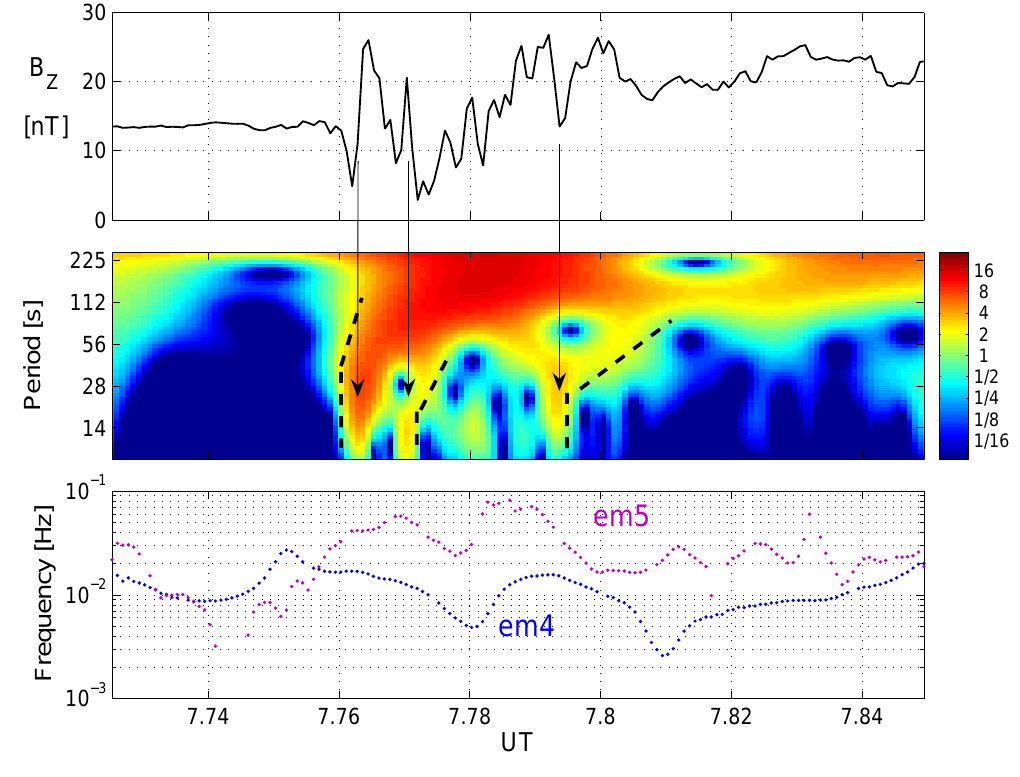
Fig. 4. Top: magnetic field time series; Middle: Wavelet time-period-energy representation; Bottom: Hilbert-Huang time-instantenous frequency representation; Thick dashed lines in the middle indicate the wavelet time-scale evolution in time; Line arrows show the locations of short time-scale (high-frequency) activations occurring simultaneously with the largest jumps in B Z